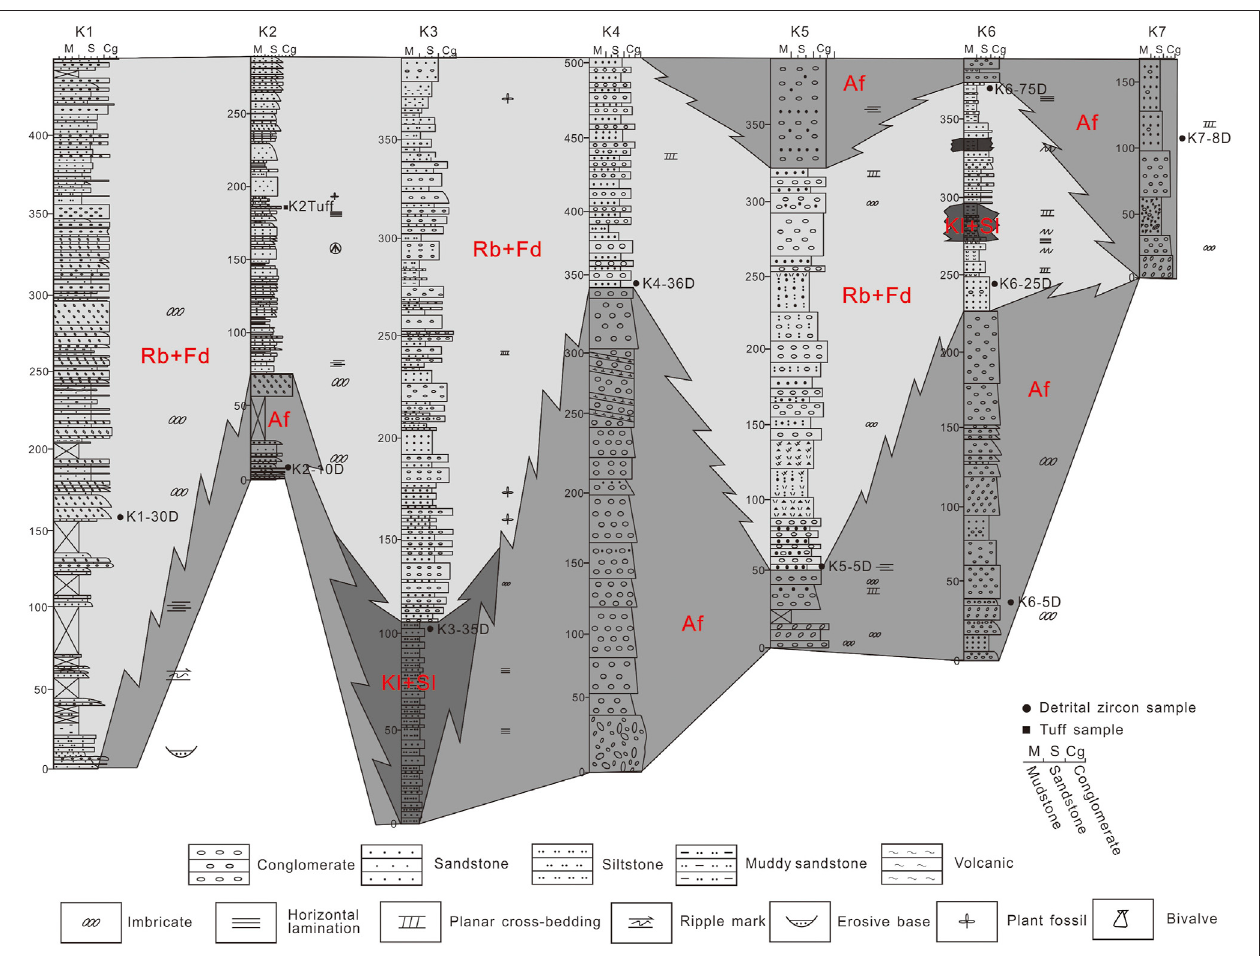
FIGURE 4 | Sedimentary facies correlations among measured Gangdese conglomerate sections (section locations shown in Figure 1 ). Stratigraphic height is in meters. AF, Alluvial fan; Rb, Braided river; Fd, Fan delta; Kl and Sl, Lacustrine.